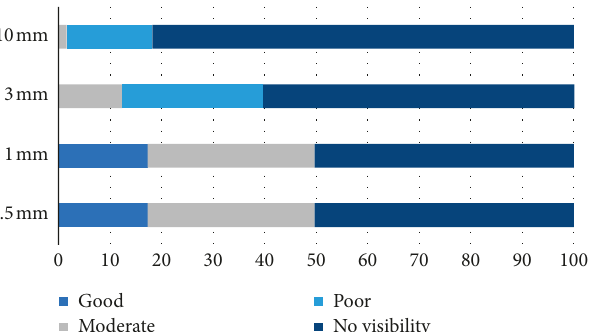
Figure 2: CS visualization with the four-point rating scale: no visibility—important structures are not visualized; poor—important structures are not diagnostic; moderate—important structures are diagnostic but could be improved; good—important structures are optimally